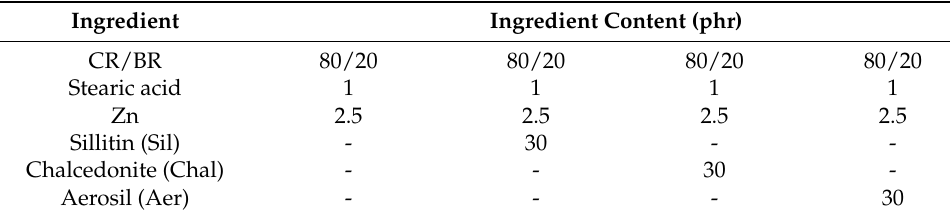
Table 1. Formulations of the CR/BR